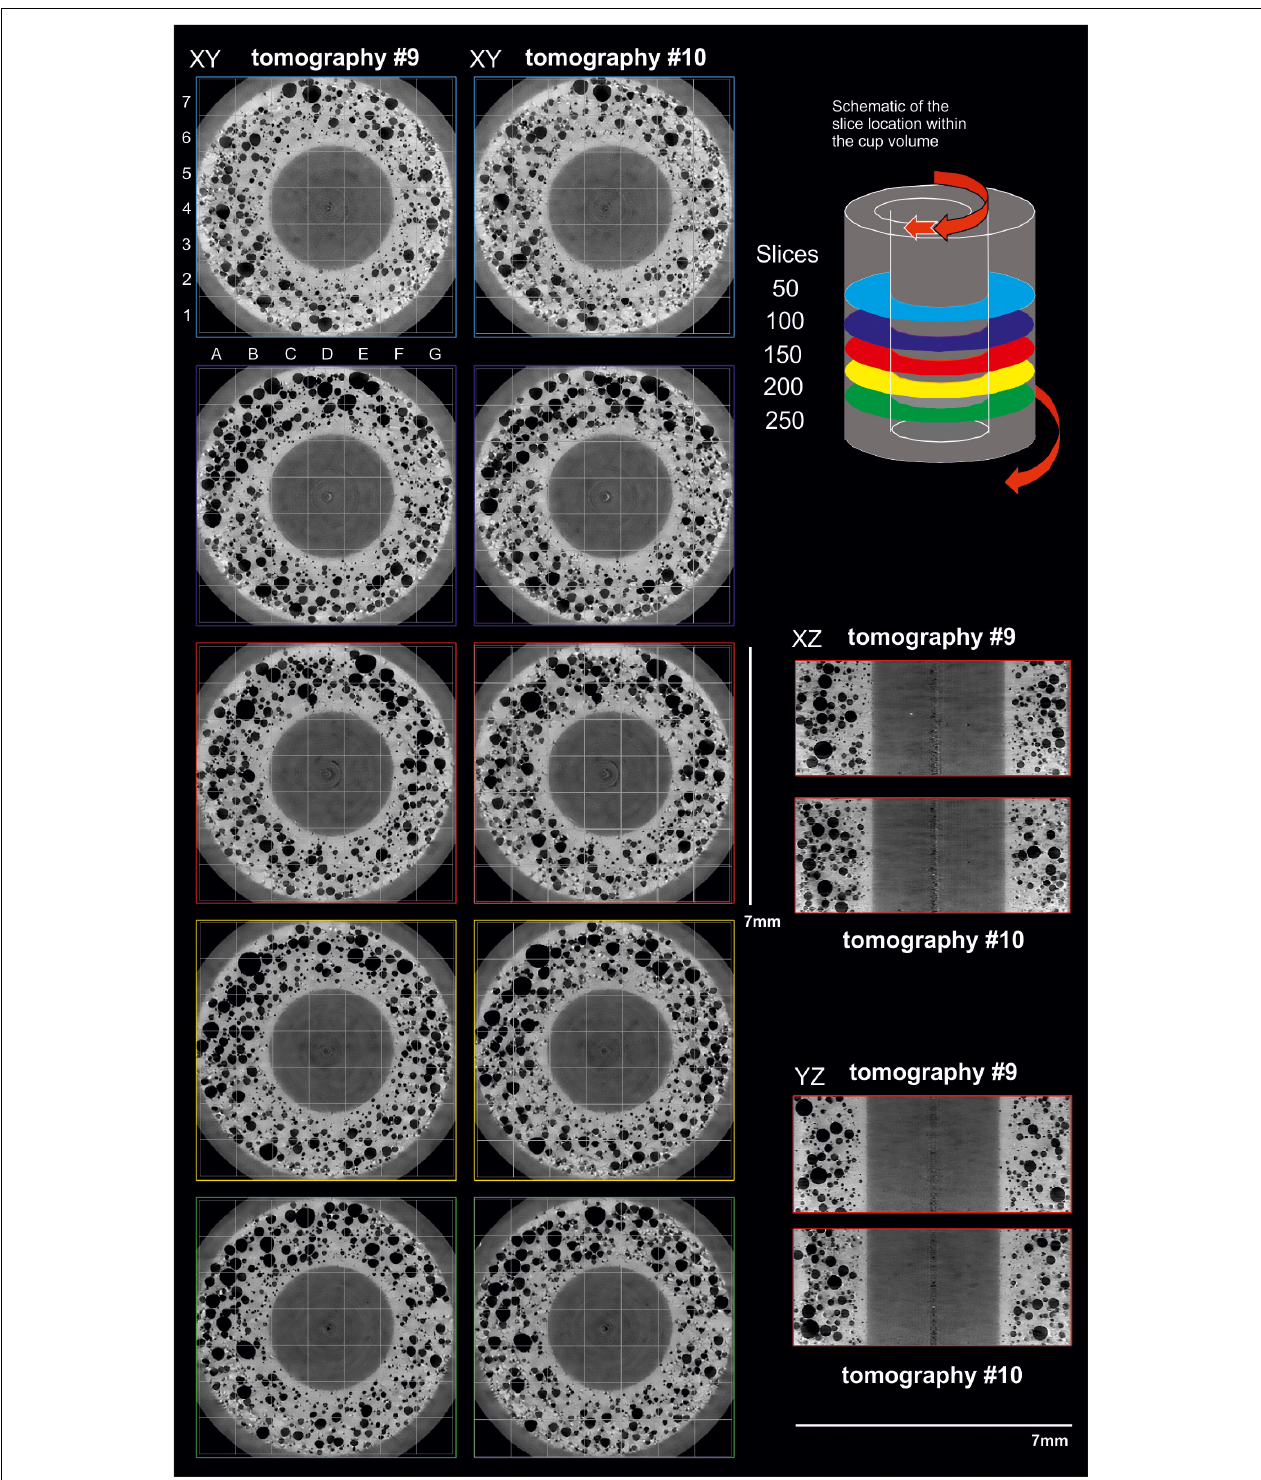
FIGURE 5 | Two-dimensional grayscale slices perpendicular to the rotation axis showing the same slices from the 9th and 10th tomographies at different heights within the sample. The upper right schematic shows the location of the slices within the sample volume: light blue = slice 50, dark blue = slice 100, red = slice 150 (mid-point), yellow = slice 200, green = slice 250, as shown in the image border color. #9 and 10 are at the onset of acceleration when spindle speed = 0.02 rpm clockwise. In the image data, the black regions are bubbles (or air outside the cup), the mid gray is the ceramic of the spindle and cup, and the pale gray is the borosilicate melt. A 7 × 7 gray grid has been overlaid on all XY images to assist in identifying the displacements and the features discussed in the text.